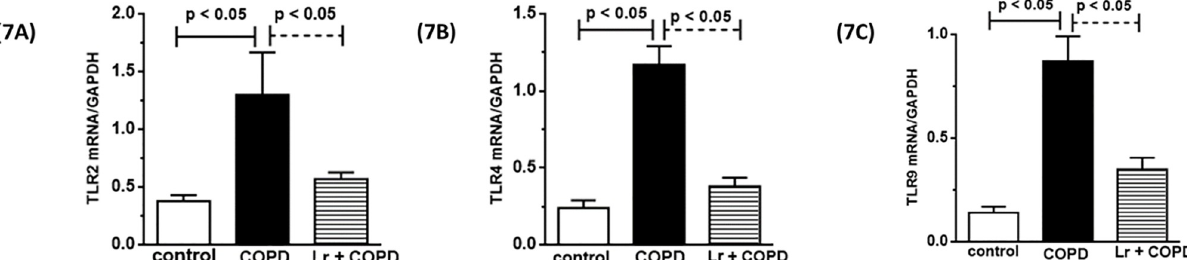
Fig 7. Toll-like receptors in lung tissue. After exposure of C57Bl/6 male mice to cigarette smoke and treatment with Lactobacillus rhamnosus ( Lr ), the mRNA expression for TLR2 (7A), TLR4 (7B) and TLR9 (7C) in lung tissue of control, COPD and Lr + COPD groups was evaluated through Real Time- PCR. The values were normalized by the GAPDH expression and expressed by arbitrary units. Each bar represents mean ± SEM from 7 different animals. The experiments were performed in triplicate. Results were considered significant when p < 0.05.